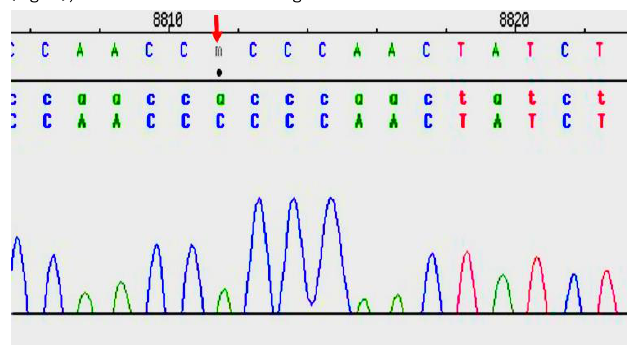
Fig. 1. Snapshot from SeqScape v2.6. m.8812 A>C mutation in cancer patient’s blood sample. The red arrow shows the mutated